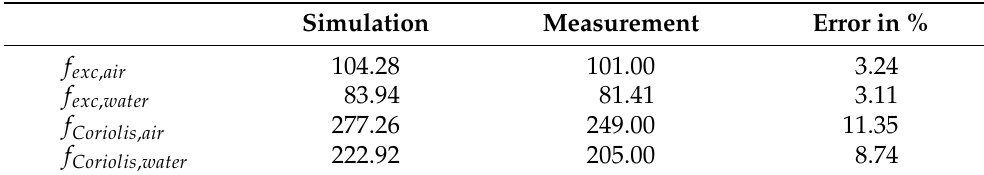
Table 5. Excitation and Coriolis twist frequency for water- and air-filled tubes in comparison to measurement data.